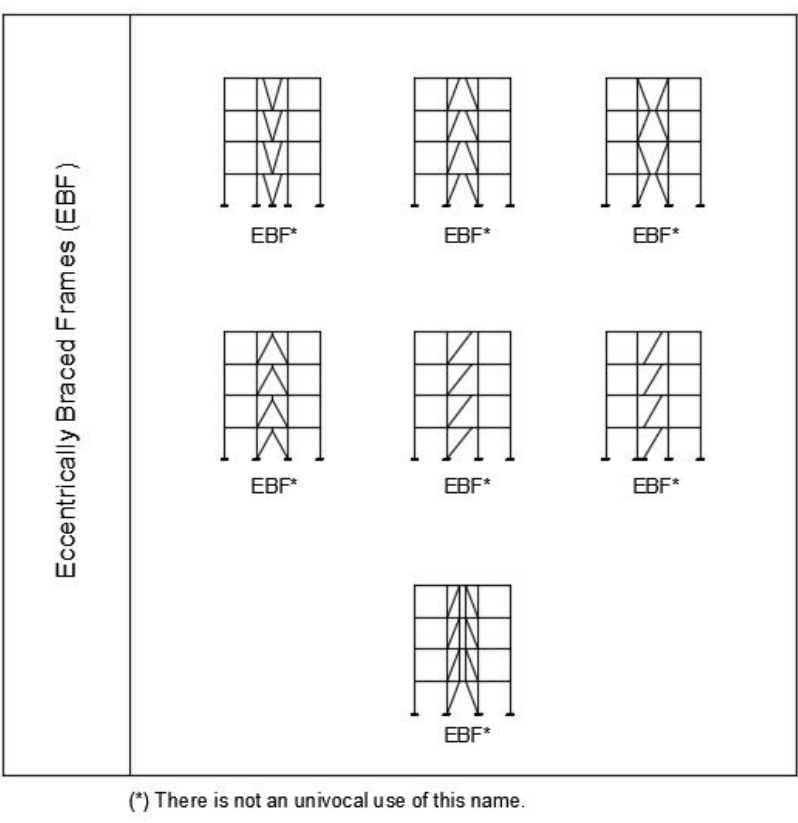
Figure 12. Nomenclature for the main types of eccentrically braced frames.